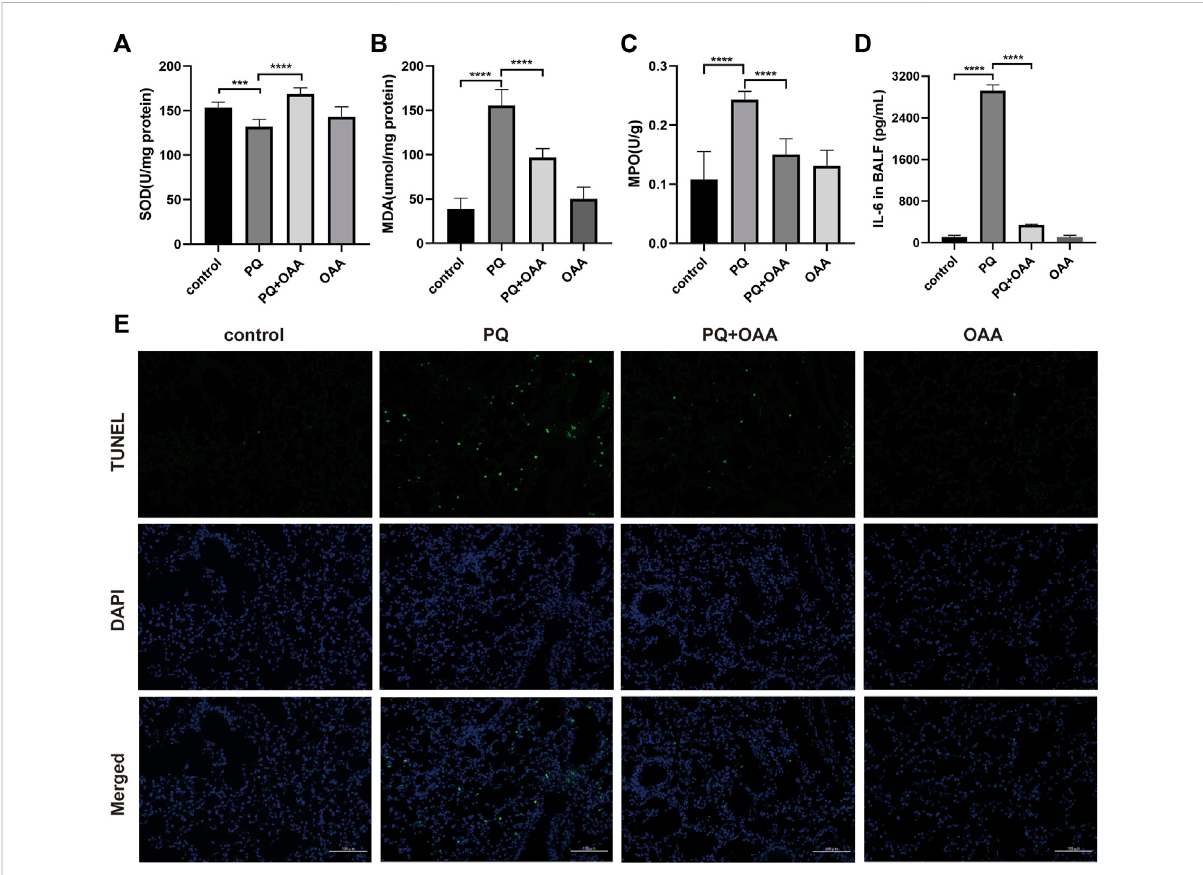
FIGURE 2 OAA alleviates oxidative stress, in fl ammation factor and apoptosis in mice after PQ poisoning. (A) SOD activity in mice lungs. (B) MDA levels in mice lungs. (C) MPO activity in mice lungs. (D) IL-6 levels in BALF. (E) Representative images of TUNEL staining (green) and DAPI staining (blue) ( × 200). Data are presented as mean ± SD ( n = 6). * p ＜ 0.05, ** p ＜ 0.01, *** p ＜ 0.001, **** p ＜ 0.0001. PQ, paraquat; OAA, oxaloacetate acid; BALF, bronchoalveolar lavage fl